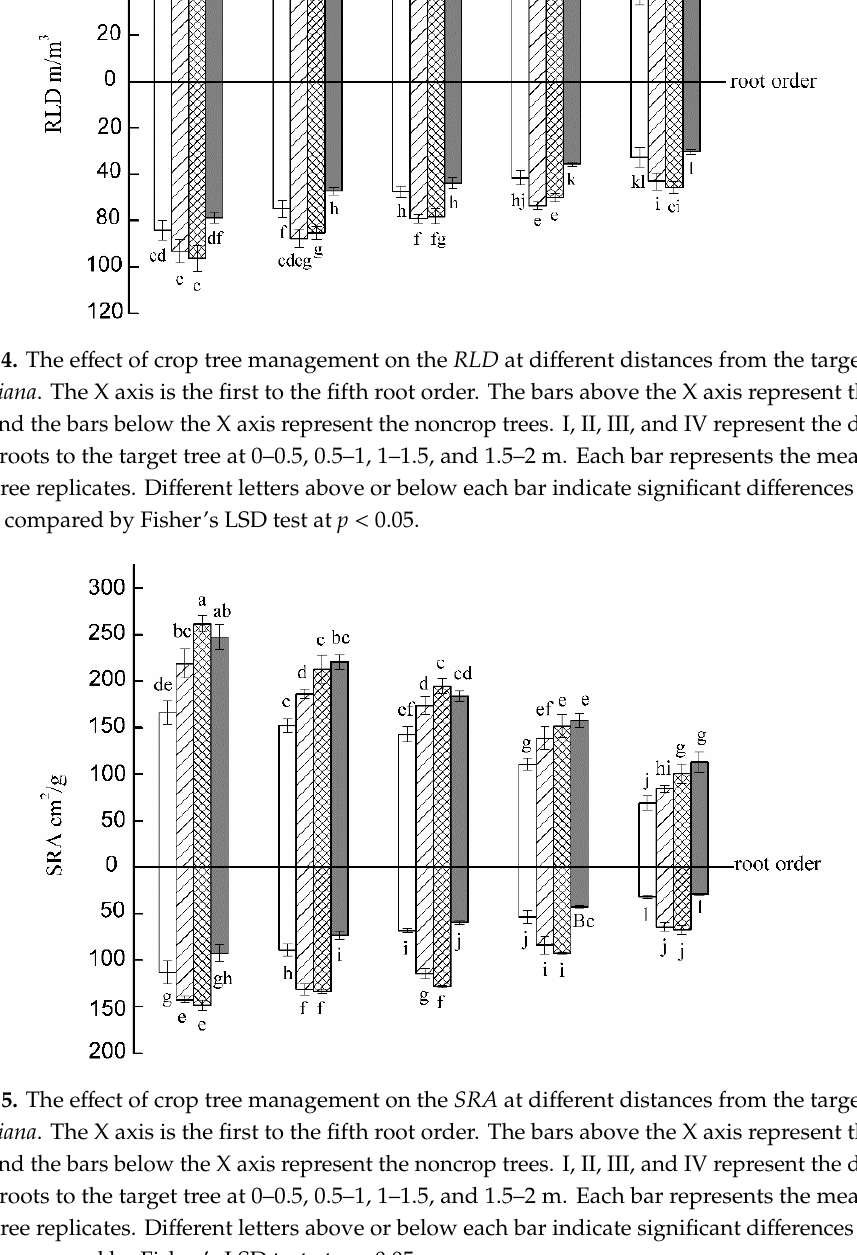
Figure 5. The e ff ect of crop tree management on the SRA at di ff erent distances from the target Pinus massoniana . The X axis is the first to the fifth root order. The bars above the X axis represent the crop trees, and the bars below the X axis represent the noncrop trees. I, II, III, and IV represent the distance of fine roots to the target tree at 0–0.5, 0.5–1, 1–1.5, and 1.5–2 m. Each bar represents the mean ± SD with three replicates. Di ff erent letters above or below each bar indicate significant di ff erences among groups compared by Fisher’s LSD test at p < 0.05.